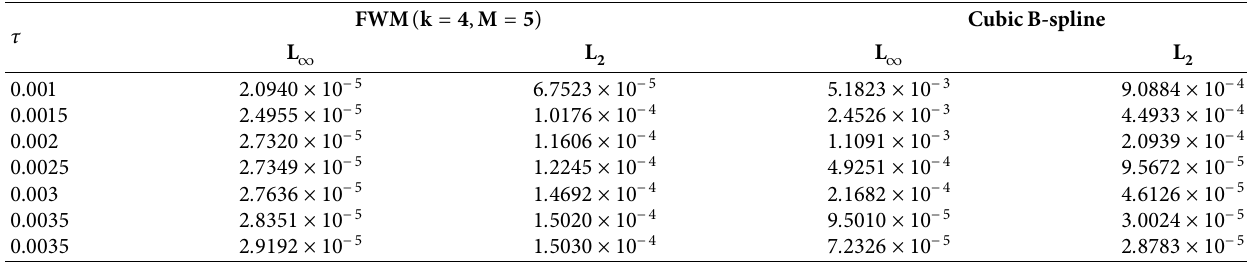
Figure 11: (a) Approximate solution, (b) exact solution, and (c) absolute error of Example 4 at α Table 5: Comparison of L and L norm errors of proposed method with cubic B -spline method [24] at α ∞ 2 k � 4 , M � 5.